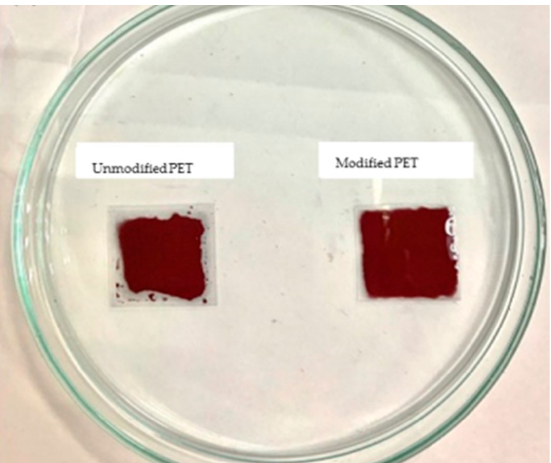
Figure 14. Adhesive status on modified and unmodified PET substrates.